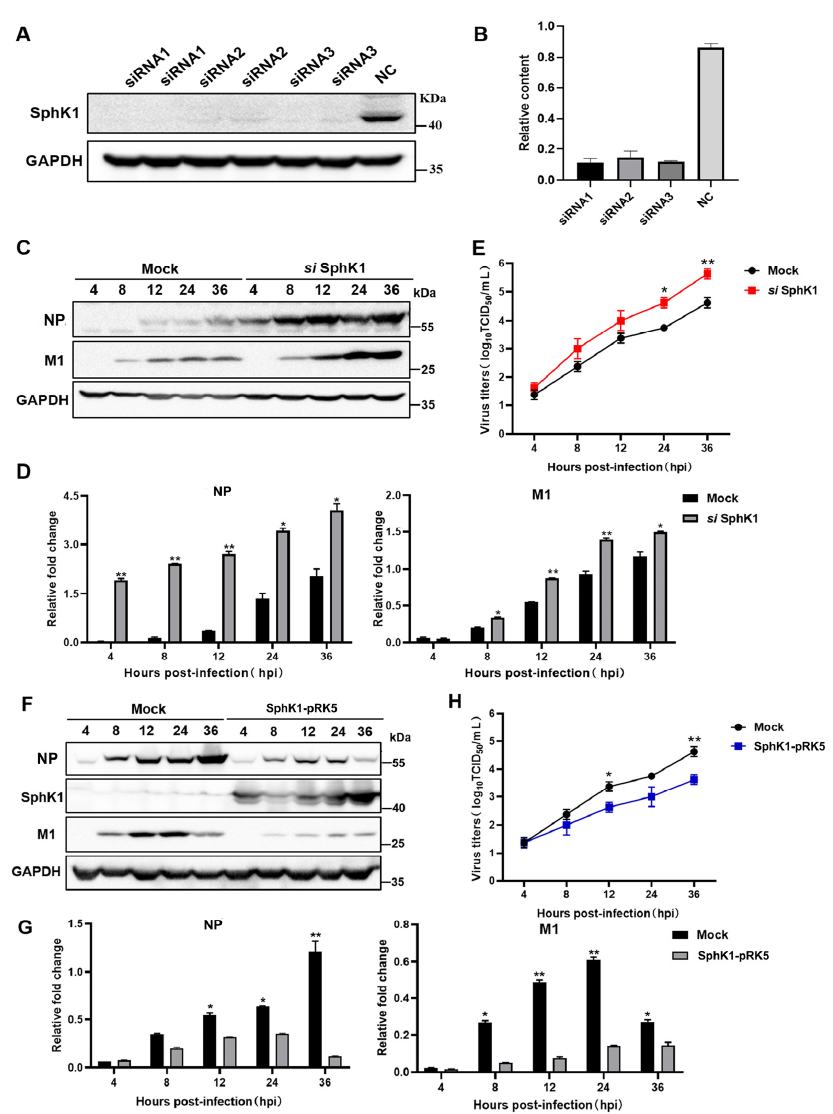
Figure 4. SphK1 protein inhibits H9N2 virus protein expression and virus replication in A549 cells. ( A ) Three designed siRNAs targeting SphK1 and negative control (NC) were transfected into A549 cells, and cells were collected 24 h after transfection for western blotting (WB) detection and ( B ) densitometry analysis and quantification; ( C ) siRNA 1 and NC was pretransfected into A549 cells, the virus was then infected with the virus at MOI = 0.5, and the cells were collected for WB at 4, 8, 12, 24 and 36 h after infection, and the expression levels of viral NP, M1 and GAPDH proteins were detected and performed ( D ) densitometry analysis Quantification; ( E ) siRNA 1 was pretransfected into A549 cells, and then the cells were infected with the virus at MOI = 0.5. Cell supernatants were collected at 4, 8, 12, 24 and 36 h after infection for TCID 50 assay to determine virus titer. ( F ) The SphK1-pRK5 (SphK1-Flag-pRK5) and Flag-pRK5 empty vector was pretransfected into A549 cells, then the cells were infected with the virus at MOI = 0.5, and the cells were collected for WB at 4, 8, 12, 24 and 36 h after infection. Detect the expression levels of SphK1, viral NP, M1 and GAPDH proteins and perform ( G ) densitometry analysis and quantification; ( H ) The constructed SphK1 eukaryotic expression vector was pretransfected into A549 cells, and then the cells were infected with the virus at MOI = 0.5. Cell supernatants were collected at 4, 8, 12, 24 and 36 h after infection for TCID 50 assay to determine virus titer. GAPDH was used as a loading control. Shown in the figure is the mean ± SD of the results of 3 trials. Differences were considered statistically significant at p < 0.05 (* p < 0.05, ** p < 0.01,